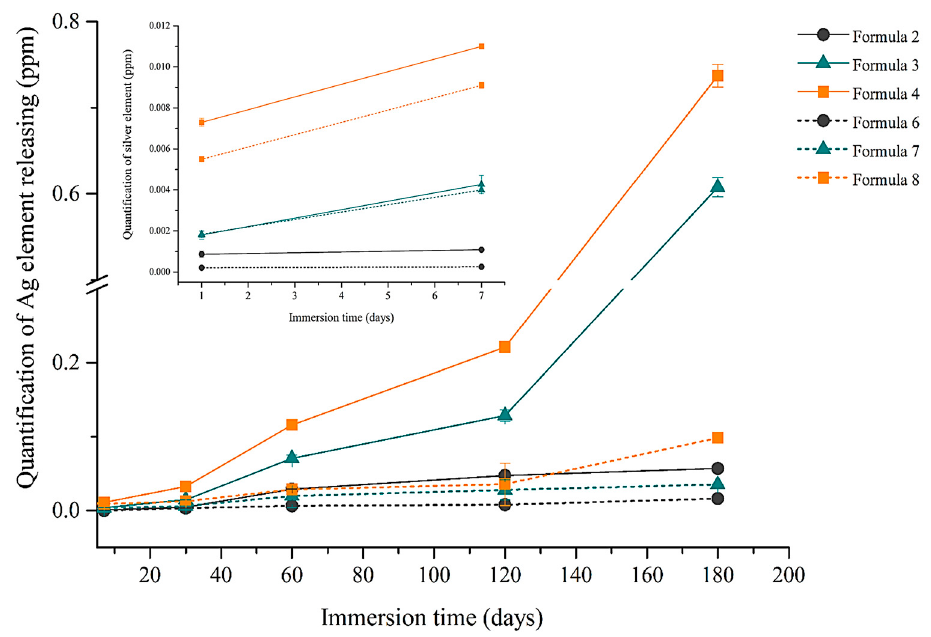
Figure 6. The kinetics of silver nanoparticles and silver ion release of the six coatings from a period of 1 day to 180 days.